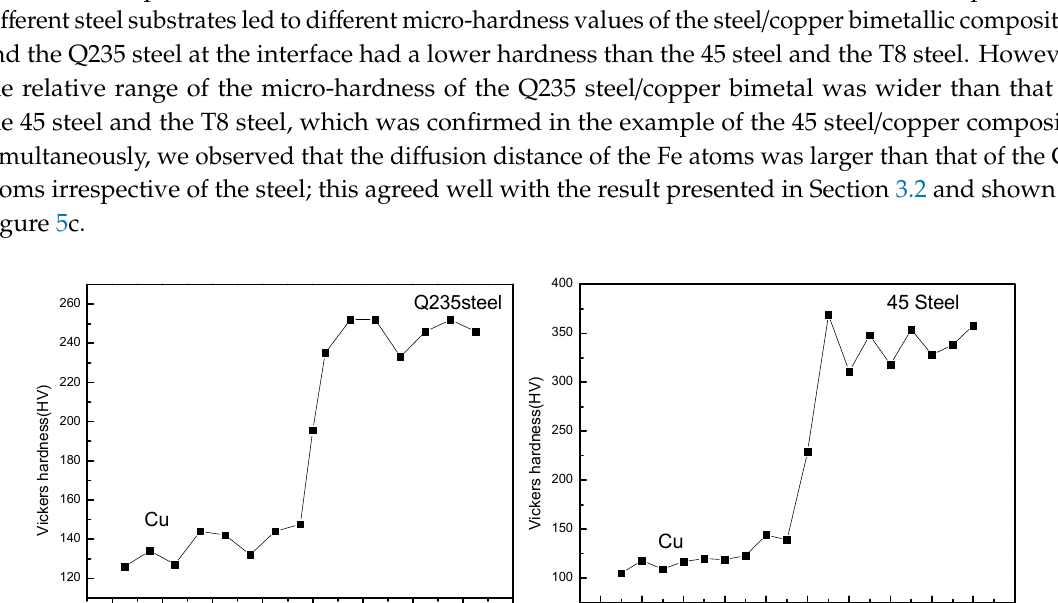
Figure 10. Micro-hardness profiles across the interfaces of the steel/copper bimetals.